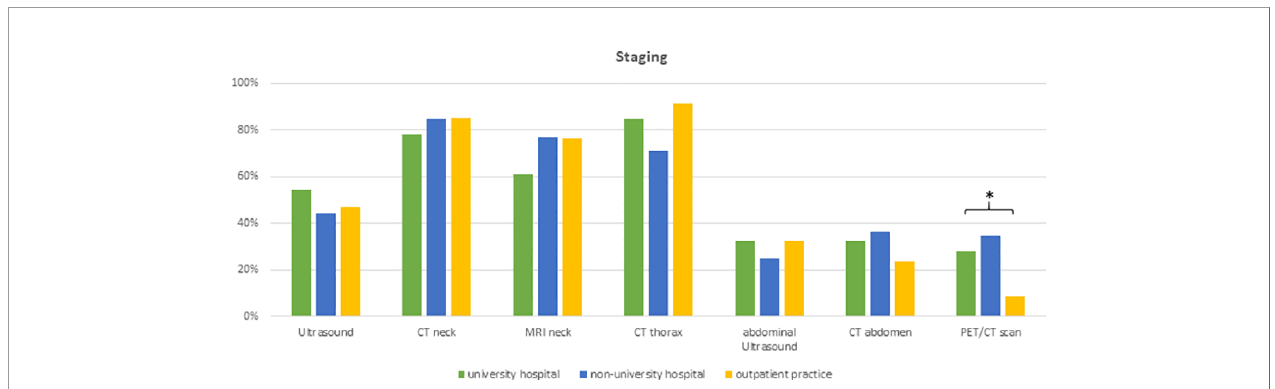
FIGURE 3 | Bar charts indicating the usage of different imaging modalities in staging, separated for responders ’ type of facility (n=131). * indicating p <0.05 Pearson ’ s chi-squared test. (CT, computed tomography; MRI, magnetic resonance imaging; PET, positron emission tomography).